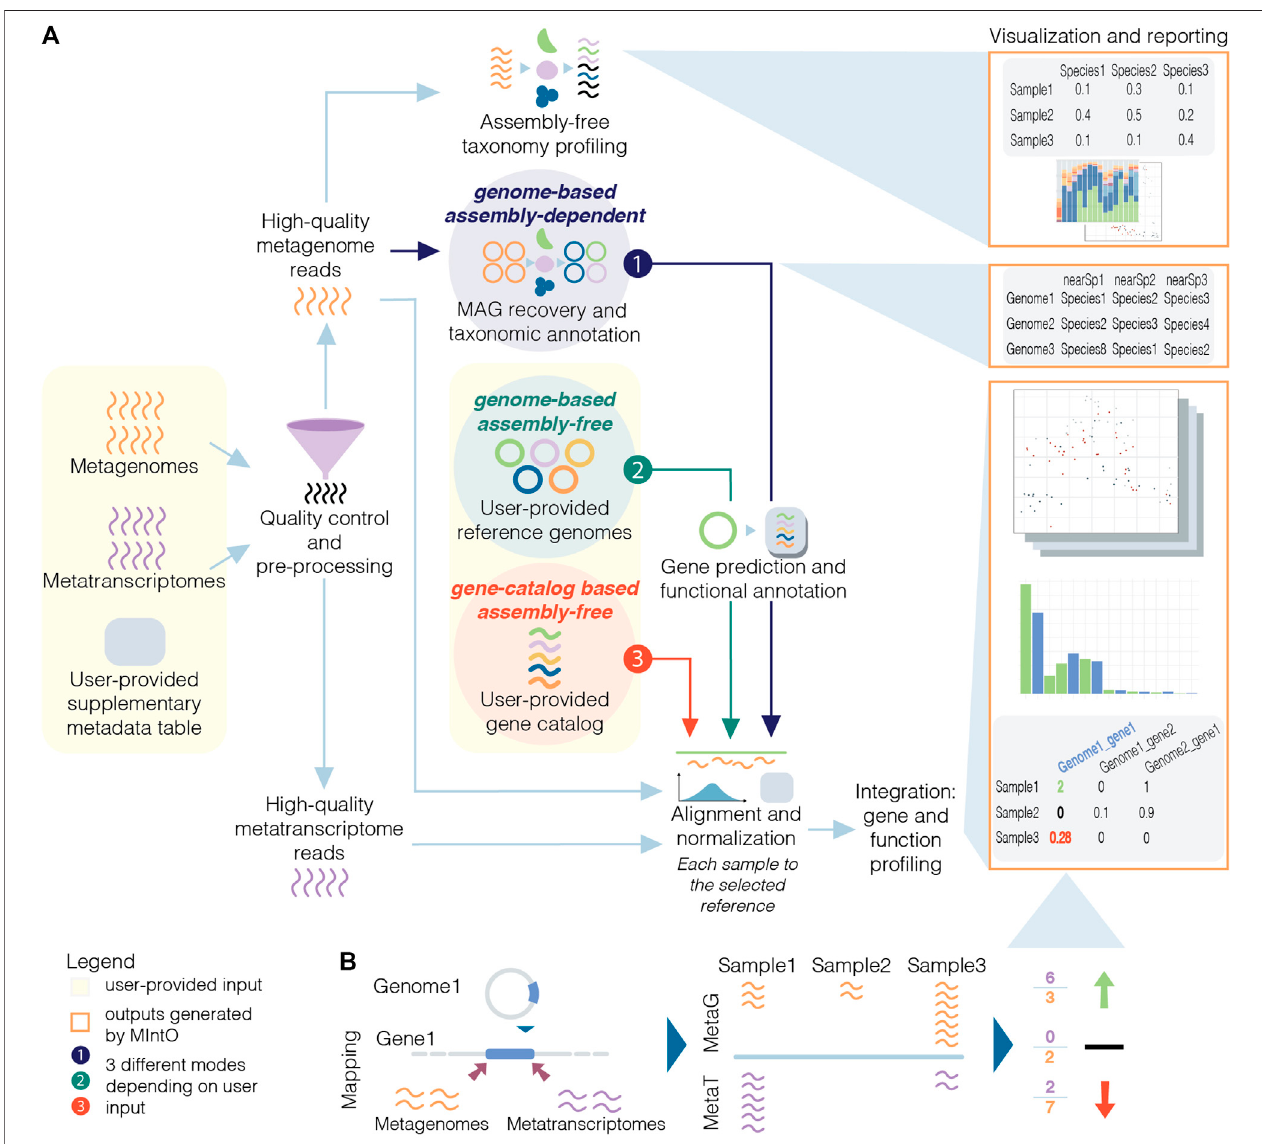
FIGURE 1 | Schematic overview of metagenomic and metatranscriptomic integration to quantify gene expression levels. (A) Three modes are available based on the input data and the experiment design: the genome-based assembly-dependent mode (1, in dark purple) recovers MAGs from metagenomic samples, while the genome-based assembly-free (2, in dark green) and the gene-catalog-based assembly-free (3, in red) modes use publicly available genomes or a gene catalog, respectively, provided by the user. In the three modes, the pipeline work fl ow includes quality control and preprocessing; assembly-free taxonomy pro fi ling ofhigh- quality metagenomic reads (in orange) by identifying phylogenetic markers (coloured); alignment of the high-quality reads to the selected reference and normalization; integration:geneandfunctionalpro fi ling;andvisualizationandreporting.ThegenepredictionandfunctionalannotationstepisrunusingtherecoveredMAGs(mode1)or publicly available genomes (mode 2). (B) The variation of gene expression depends on the abundance of transcripts from the organisms in the community and/or by changes in the abundance of these members and their related genes (community